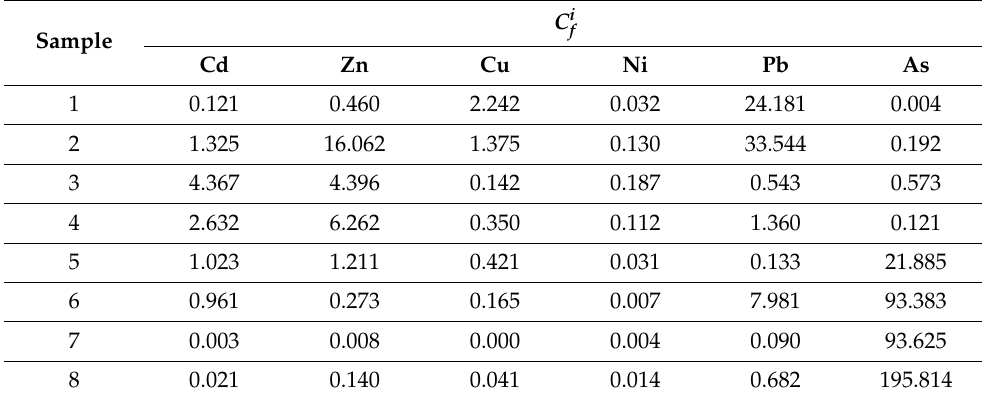
of heavy metals in f